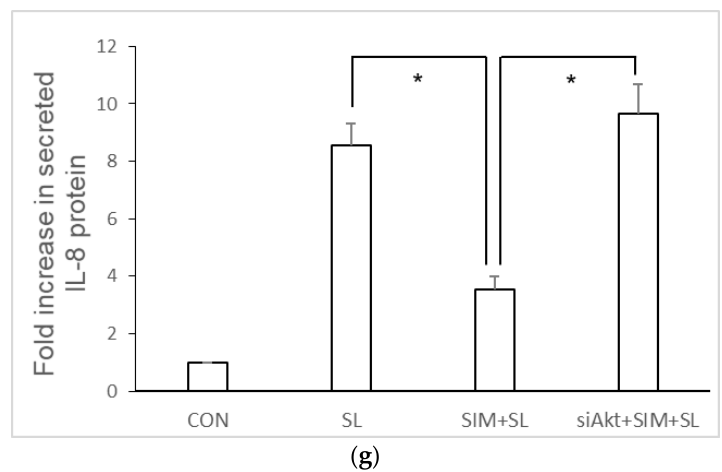
Figure 2. Involvement of Akt signaling pathways in the simvastatin-mediated suppression of IL-8 expression in Salmonella -infected SW480 cells. SW480 cells were transfected with control and Akt siRNAs (siAkt = siRNA against Akt) for 48 h. The untransfected or transfected cells were left uninfected or infected with the wild-type S. Typhimurium strain SL1344 (SL) for one hour in the presence or absence of 10 μM simvastatin (SIM) or PI3K inhibitor LY294002 (LY). The activation of Akt and ERK was analyzed in whole cell proteins by western blotting with antibodies to phosphorylated (p) Akt and ERK. Representative immunoblots ( a ) and densitometric quantification of the immunoreactive bands of phosphorylated Akt (p-Akt) ( b ) and ERK (p-ERK) ( c ) are shown. GAPDH was used for the normalization of the cytosolic proteins. The relative band density of p-Akt in treated (white) and untreated cells (black) were quantified as fold increases compared with the untreated and uninfected control cells (CON). The results shown are representative of three separate experiments. Knockdown of Akt was confirmed by Western blot analysis ( d ). Total RNA was prepared after infection and analyzed by real-time quantitative PCR to estimate amounts of IL-8 transcript in the presence or absence of siAkt ( e ) or LY ( f ). The mRNA expression was normalized to the corresponding GAPDH expression and is shown as the fold increase over control cells. ( g ) IL-8 in the culture medium was assayed by ELISA 5 h later. The amount of secreted IL-8 was expressed as a fold increase compared to the control cells. The results indicate the means and standard deviations for duplicate wells from at least three separate experiments (* p < 0.05; N.S.: not significant).